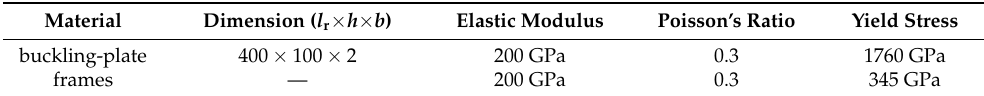
Figure 7. Finite element simulation of BPSCFD: ( a ) dimension; ( b ) stress cloud diagram; ( c ) force- displacement relationship. Table 2. Material parameters of